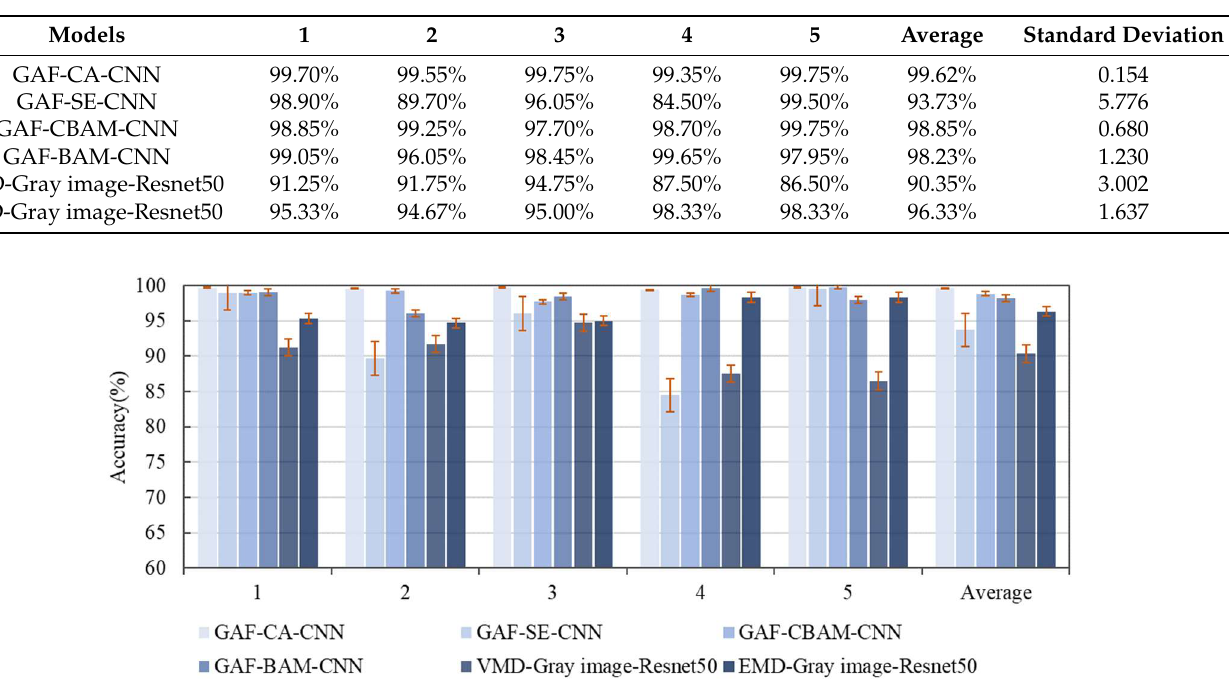
Figure 14. Comparison results between seven methods on dataset A.